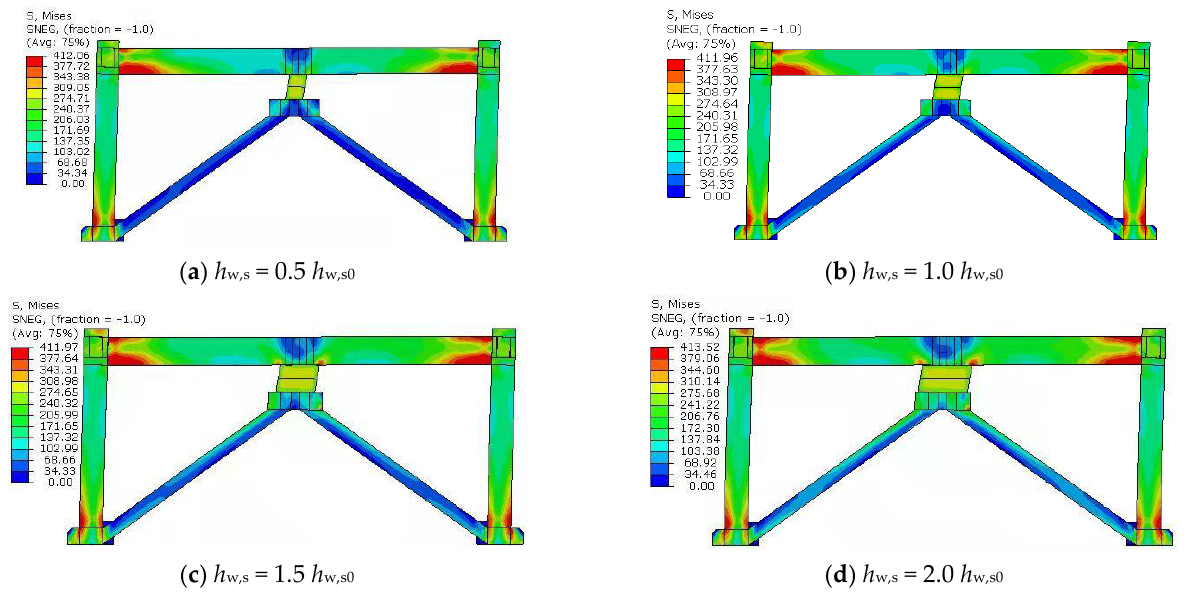
Figure 19. Stress nephograms of a steel frame for different h w,s values.